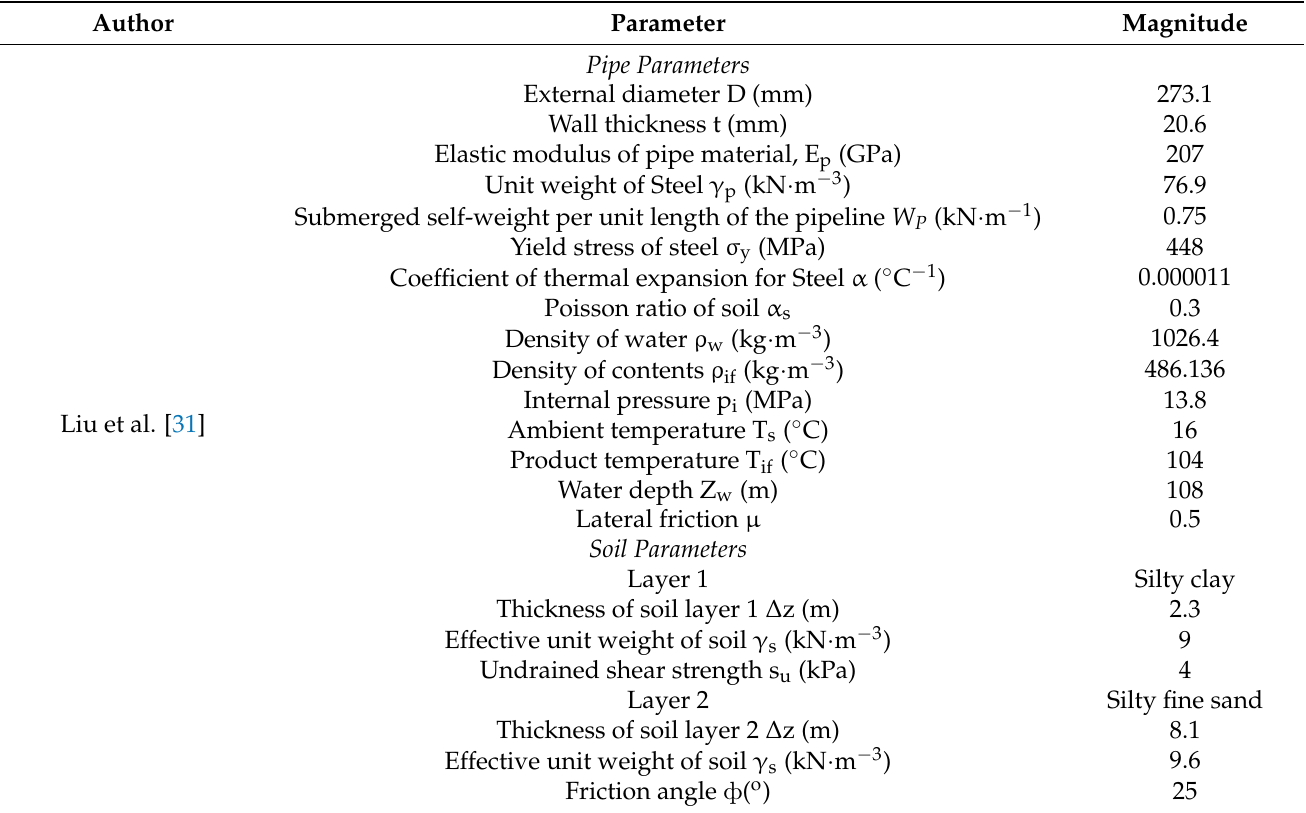
Figure 9. Pipe response during the lateral motion for pipelines with different weights [28]. Table 2. Parameter used in the Numerical models for lateral resistance of surface laid